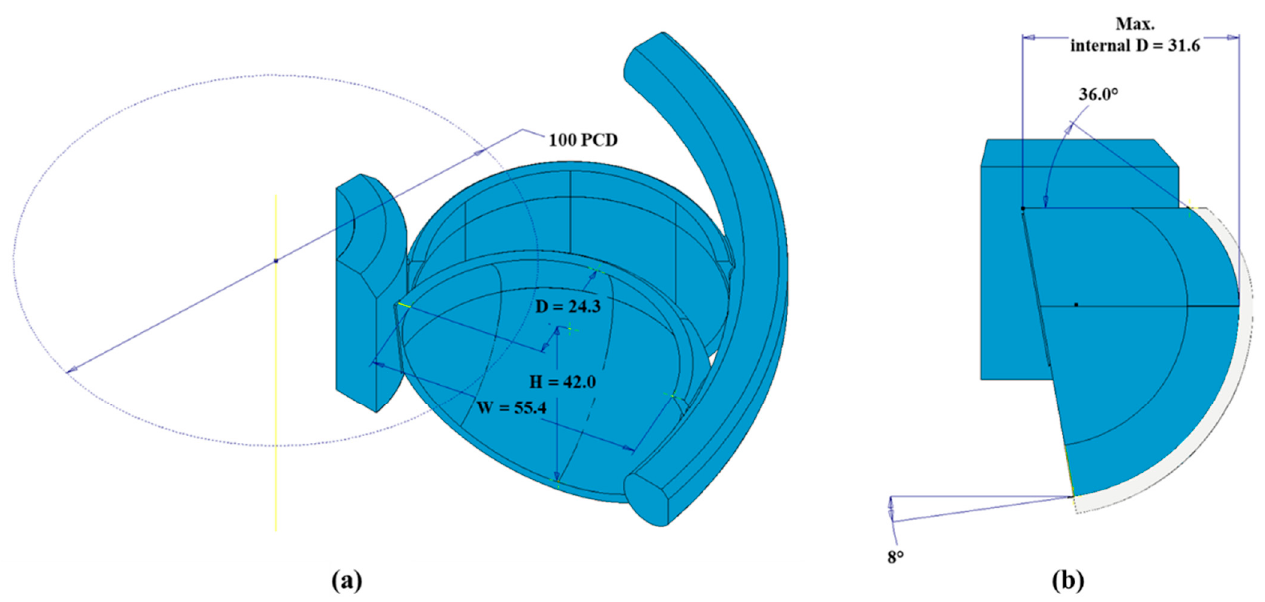
Figure 20. ( a ) The two-blade CAD model of the final runner. Refer to Figure 5 for a description of the indicated dimensions. ( b ) Section view with key dimensions in the central plane.